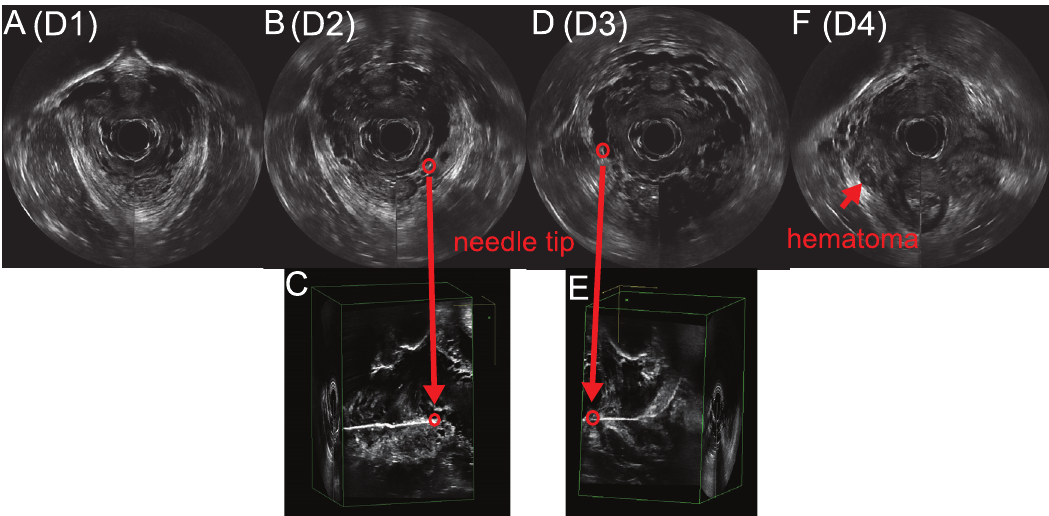
Fig 2. Four phrased 3DEVUS data collected from the same subject during biopsy examination. (A) Pre-biopsy 3DEVUS volume. (B) 3DEVUS volume with biopsy needle on the left. (C) Needle inserted on the left is more visible from a different view. (D) 3DEVUS volume with the biopsy needle on the right. (E) Needle inserted on the right viewed from the sagittal view. (F) Post-biopsy 3DEVUS volume. The development of hematoma can clearly be seen as indicated by the arrow, which showed up as a dark region at the biopsy